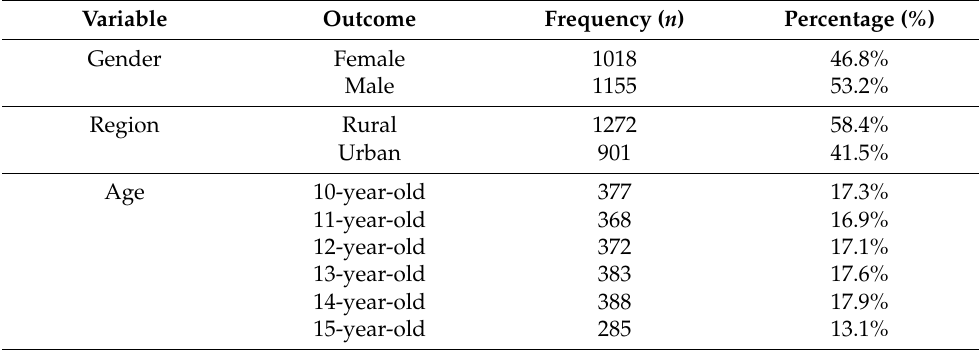
Table 2. Socio-economic Characteristics of the CFPS-2018 Participants ( n = 2173).